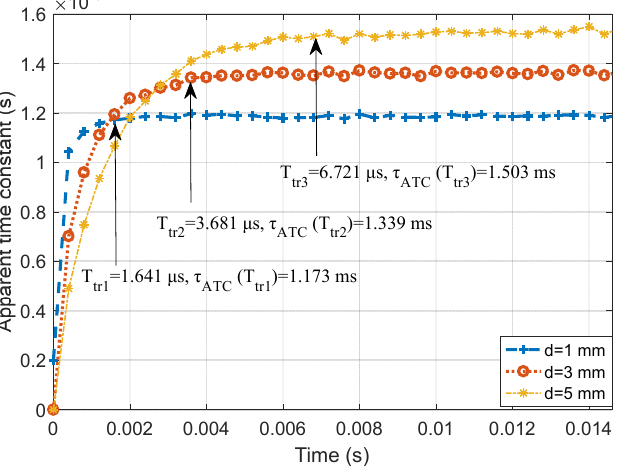
Figure 10. Measured D-ATC curve of three thickness aluminum plates with 100 mm lift-off. There is a cross between two D-ATC curves with different thicknesses, the steady-state value of the D-ATC curve is positively correlated with the thickness of the aluminum plate, and the transient time of the D-ATC curve extends with the increase of specimen thickness.